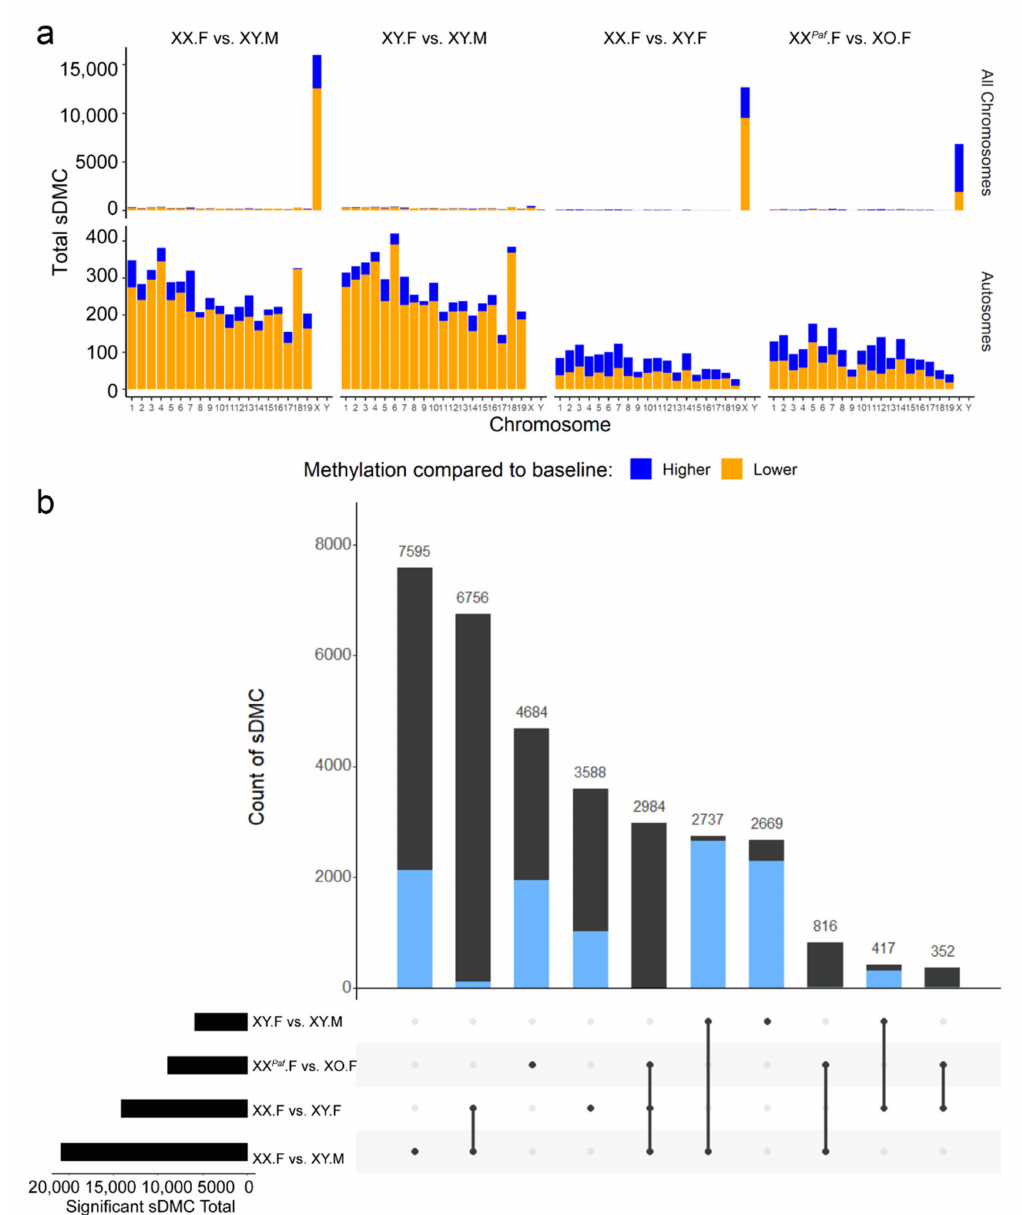
Figure 2. Phenotypic sex and sex-chromosome complement contribute to sex bias in DNA methylation. ( a ) Counts of sex-associated differentially methylated CpG sites (sDMC) per chromosome in each comparison. Top row shows the distribution of sDMC across all chromosomes. Bottom row shows the autosomal sDMC. The x -axis represents chromosome ID, and the y -axis represents the number of sDMC. Orange portion of the bar corresponds to sDMC with lower methylation compared with baseline. Blue corresponds to sDMC with higher methylation level compared with baseline. Baseline samples are XX.F (XX.F vs. XY.M), XY.F (XY.F vs. XY.M), XX.F (XX.F vs. XY.F), and XX Paf .F (XX .Paf. F vs. XO.F). ( b ) UpSet Plot shows the overlap of sDMC detected across comparisons. Each horizontal bar on the left represents the total number of sDMC identified in each comparison. Each vertical bar shows the size of a subset, while the blue and black portions represent sDMC on autosomes and sex-chromosomes, respectively. Different vertical bars are mutually exclusive, and bars with intersection size < 50 are not